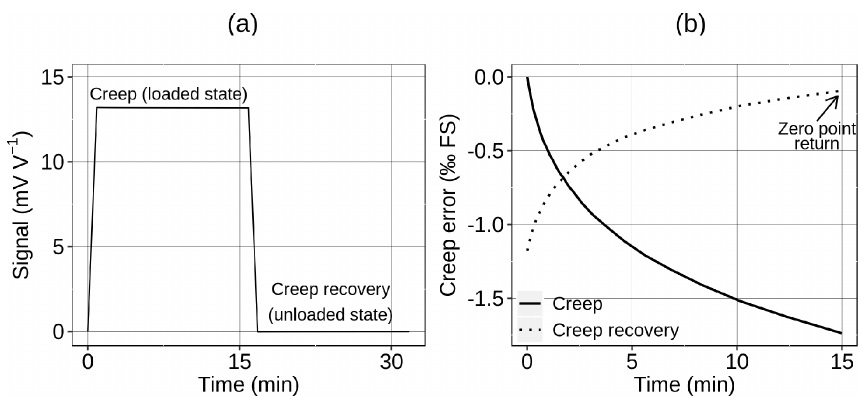
Figure 3. (a) The typical signal curve of a bending beam with a bridge circuit of Ni 90 Cr 10 − C thin-film SGs in a creep measurement consisting of the creep (loaded state) and the creep recovery (unloaded state). (b) The creep, the creep recovery and the zero point return error are referred to the full-scale (FS) signal. The creep and the creep recovery are both measured for 15min; for comparison purposes, both phases are plotted with the same timescale.